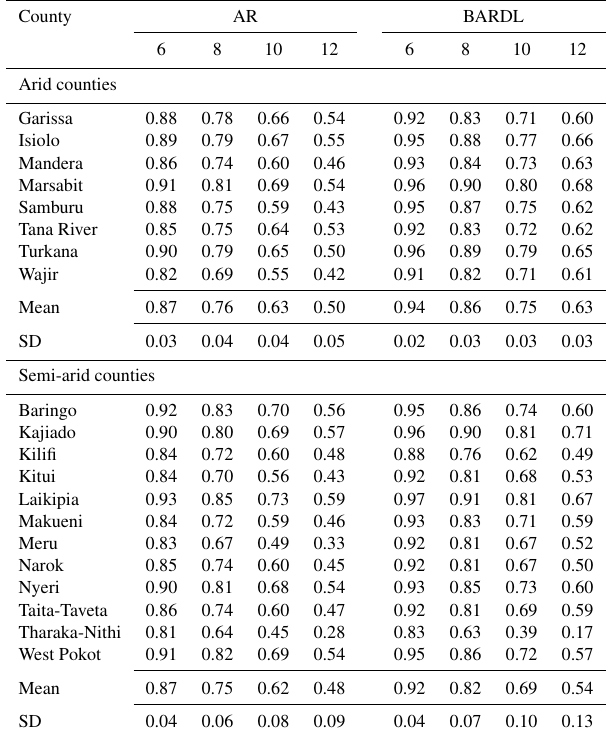
Table 2. R 2 scores (6- to 12-week lead times) for AR modelled with lags of VCI3M only and BARDL modelled with lags of VCI3M with precipitation (P3M) and soil moisture (SM3M) for arid and semi-arid counties. The mean R 2 values in this table do not corre- spond to R 2 values in Fig. 4 because Fig. 4 shows the overall scores for all counties, while the table shows the scores for the separate arid and semi-arid